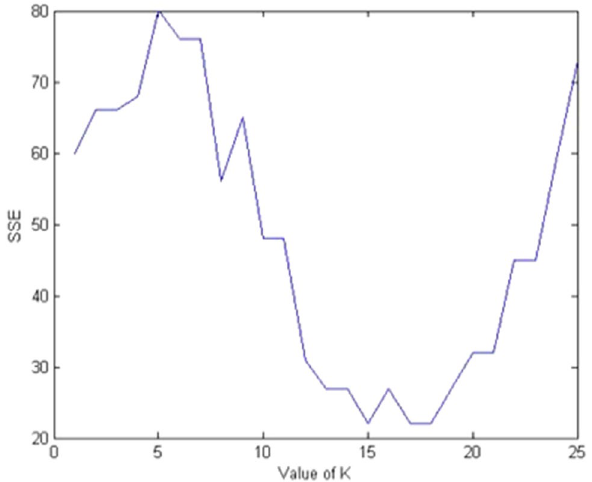
Fig. 5 The error rate for Fuzzy -kNN model according to fourfold-